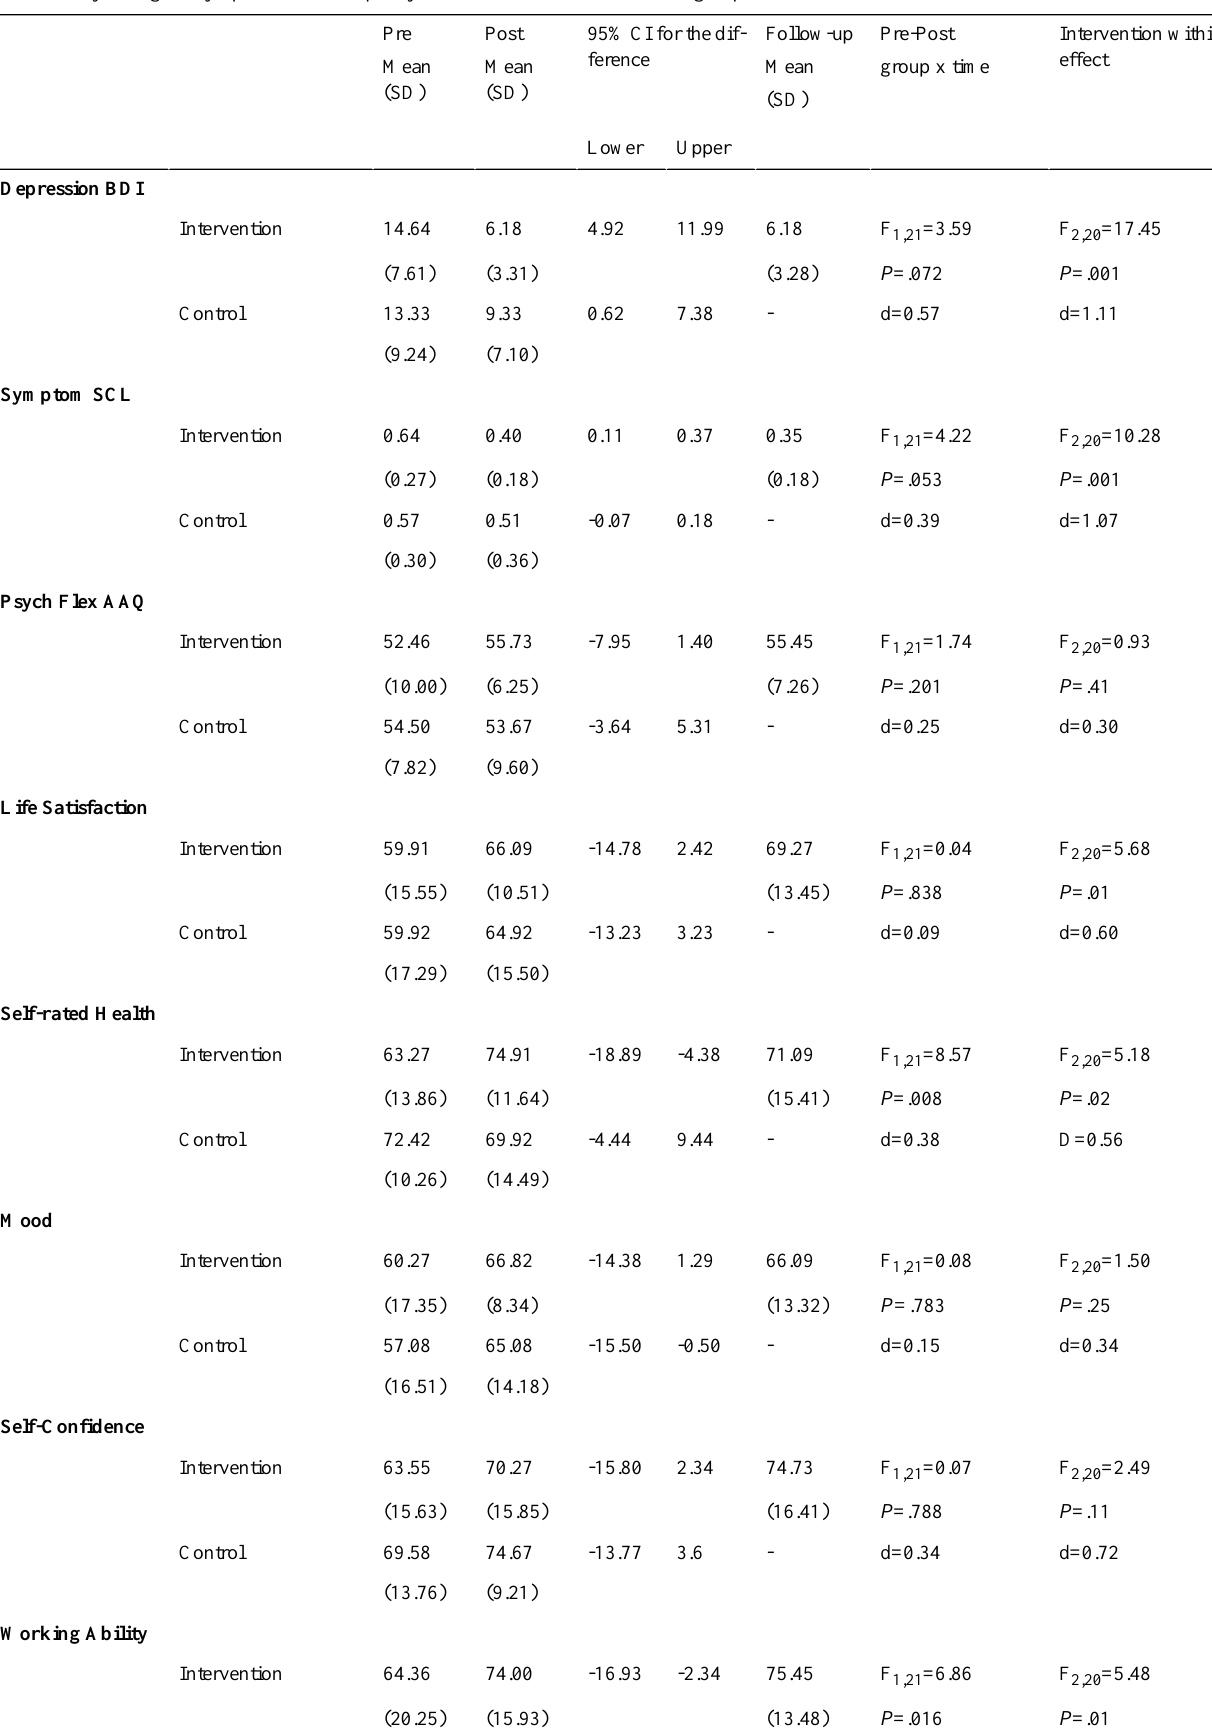
Table 3. Psychological symptoms and life quality for the intervention and control group.